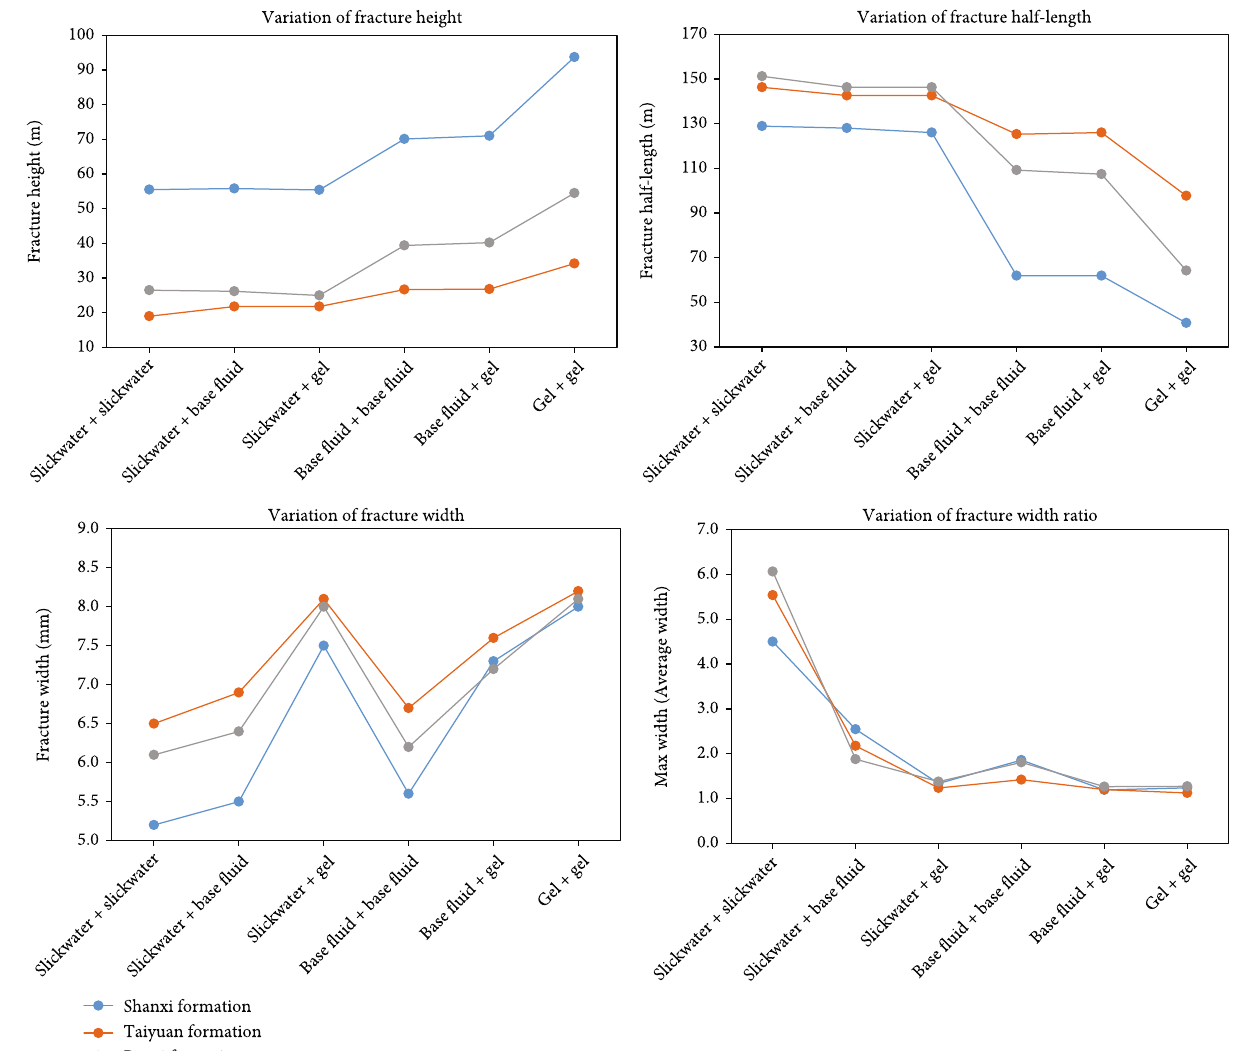
Figure 10: Variation of hydraulic fracture shape with the fracturing fl uid